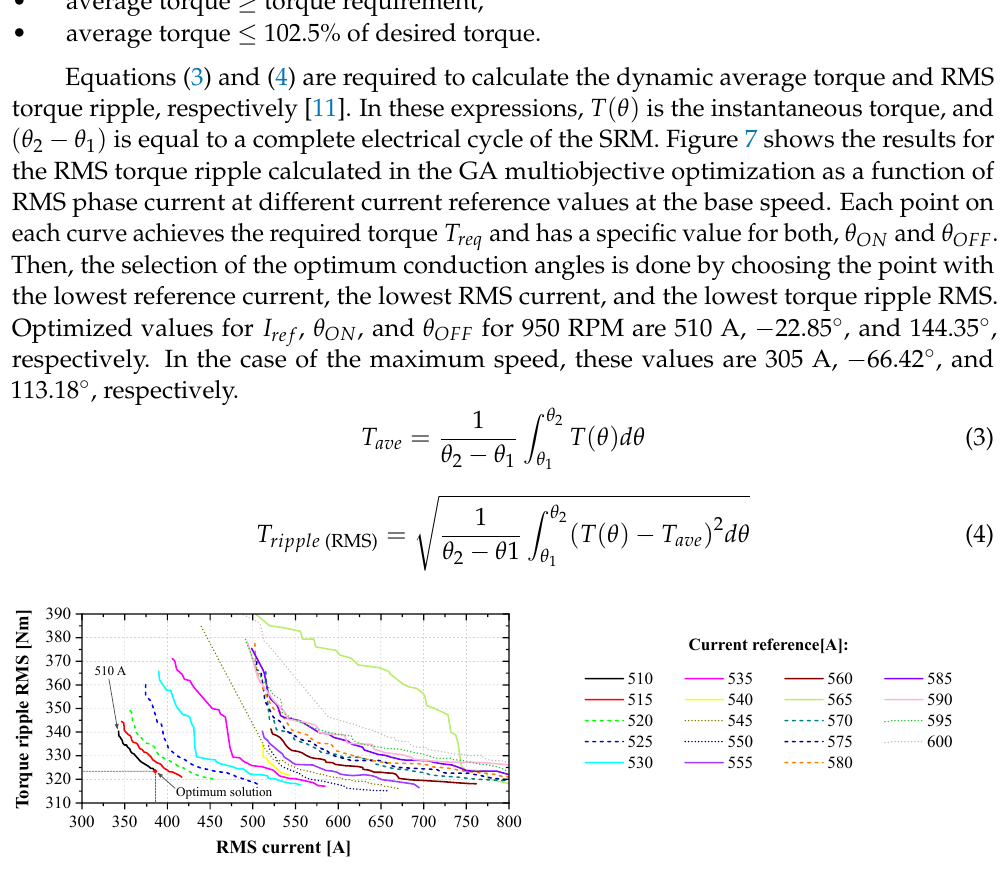
Figure 7. GA multiobjective optimization results for ω r = 950 RPM, T ref = 3400 Nm, I ref = 510, 515, . . . ,600